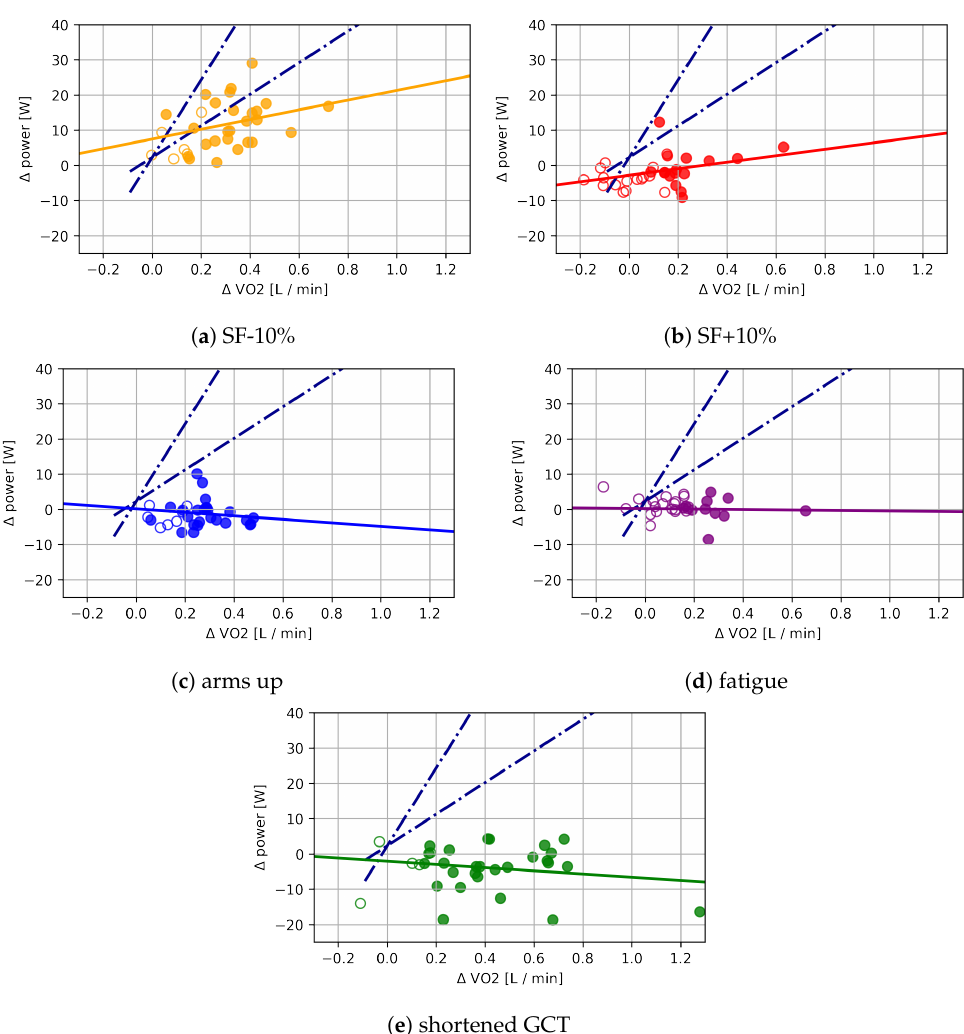
Figure 3. Relation of change in ˙ VO 2 and P W in reaction to altered running conditions or fatigue ( a – e ). The dark-blue dotted-dashed lines indicate the expected range for these points, as determined by the incremental/ramp test. Trend lines show the main direction of a linear regression, with r and the mean squared error (mse). Hollow points indicate a nonsignificant change in ˙VO 2 (the number of participants with significant changes in ˙VO 2 for each condition shown in the respective legend). The number of subjects with significant changes in ˙VO 2 for each condition was: ( a ) 26, ( b ) 16, ( c ) 25, ( d ) 11, and ( e )